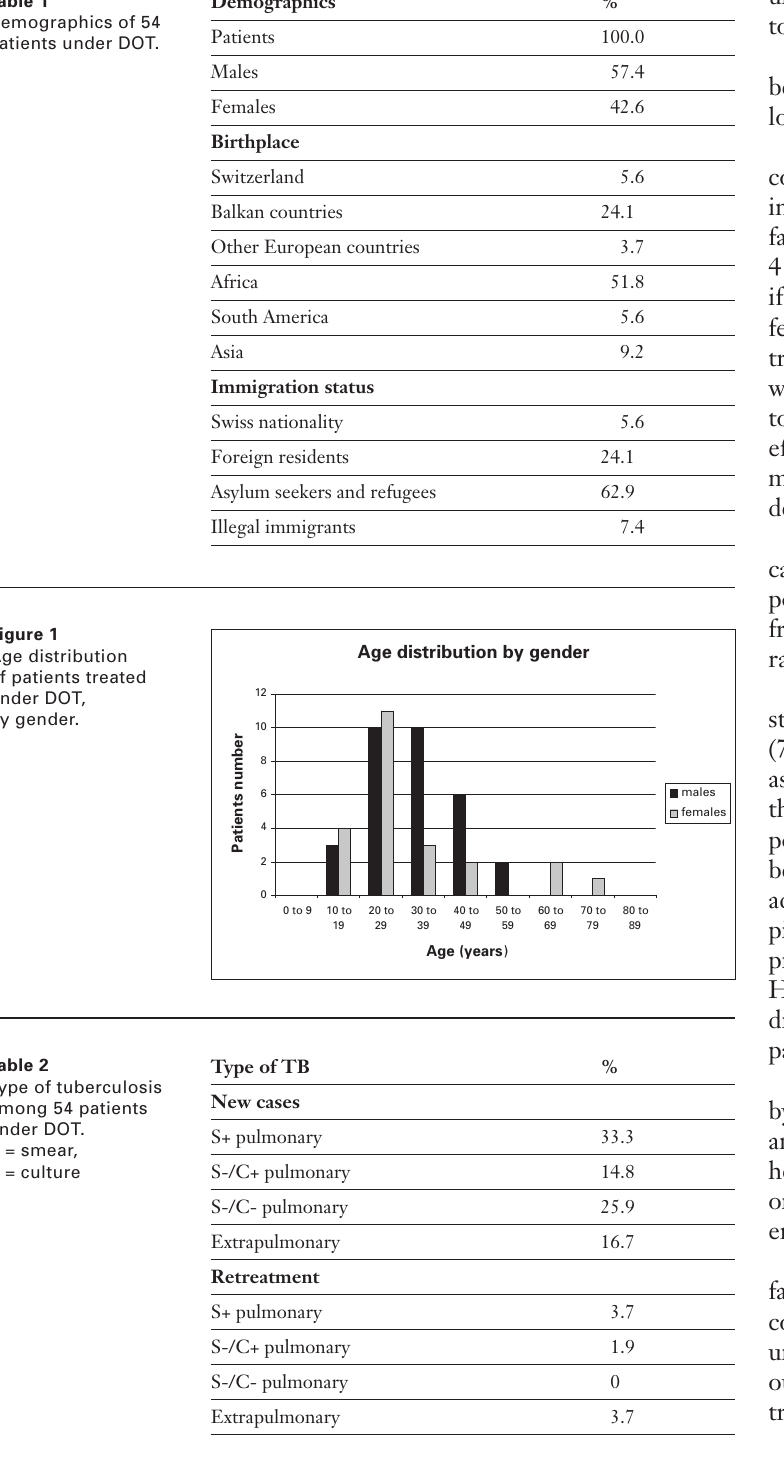
patients under DOT.